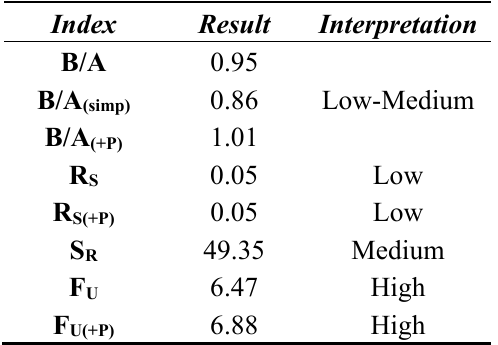
Table 4. Theoretical deposition indices for the fuel used in the experiments.